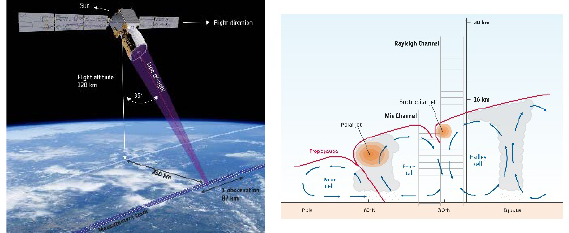
Figure 1: The Aeolus orbit, pointing and sampling characteristics (left) and an example of the vertical measurement binning by the two channels measuring winds from particle (Mie) and molecular (Rayleigh) returns